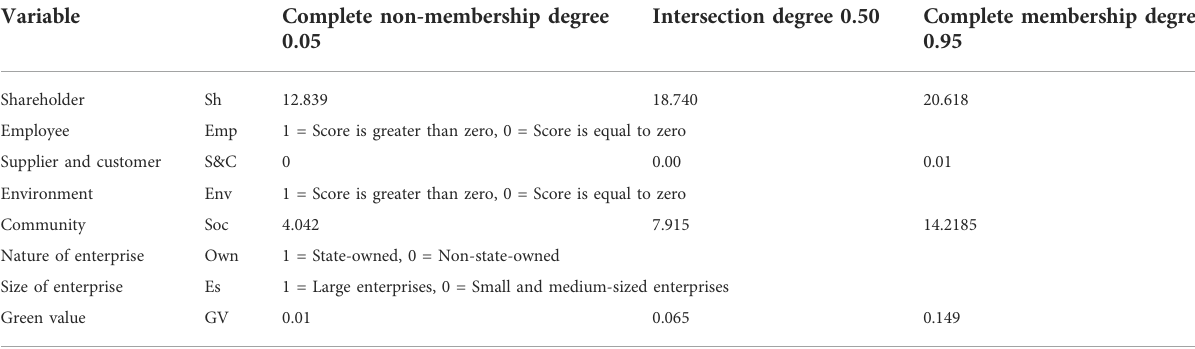
TABLE 2 Calibrated parameters by the fuzzy set qualitative comparative analysis.